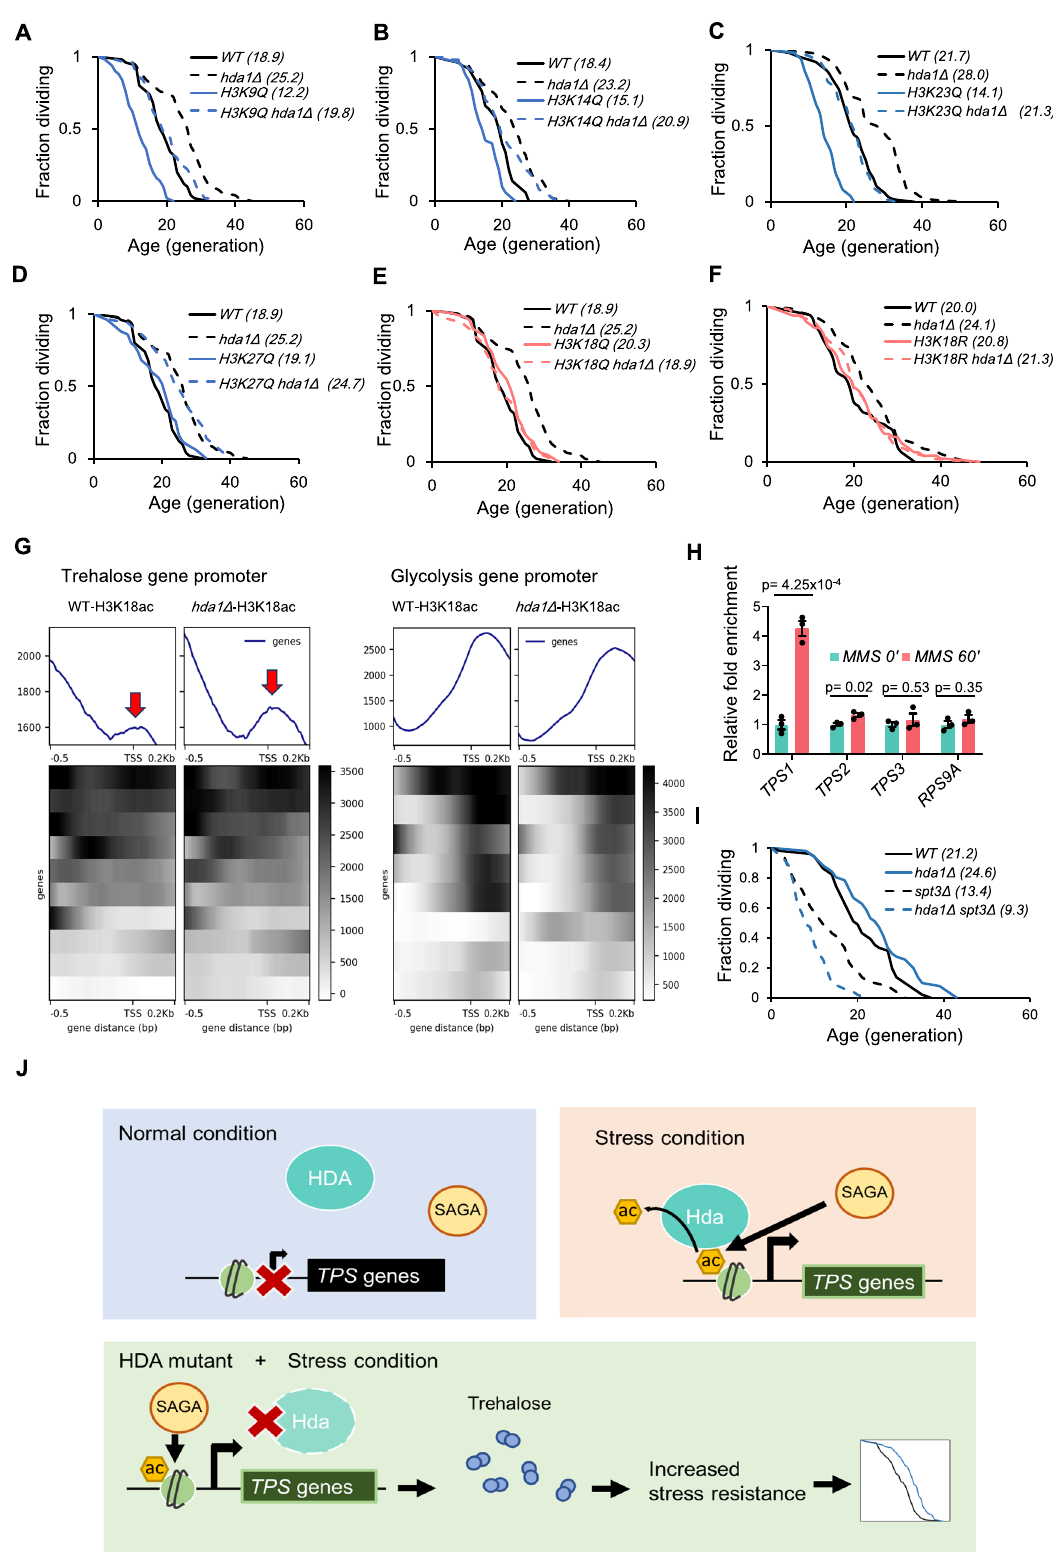
Fig. 7 The lifespan phenotypes of HDA mutants are mediated by H3K18 acetylation. A RLS of WT, hda1 Δ , H3K9Q , and hda1 Δ H3K9Q . B RLS of WT, hda1 Δ , H3K14Q , and hda1 Δ H3K14Q . C RLS of WT, hda1 Δ , H3K23Q , and hda1 Δ H3K23Q . D RLS of WT, hda1 Δ , H3K27Q , and hda1 Δ H3K27Q . E RLS of WT, hda1 Δ , H3K18Q , and hda1 Δ H3K18Q . F RLS of WT, hda1 Δ , H3K18R , and hda1 Δ H3K18R . G Metagene plot and heatmap of H3K18 acetylation on trehalose (left) and glycolysis (right) promoters as detected by ChIP- Seq. H ChIP-qPCR of Hda1-myc binding on TPS1, TPS2, TPS3 , and ACT1 promoters, under designated time after MMS treatment. Error bars represent SEM, n = 3. p -value calculated by two-sided T- test. I RLS of WT, hda1 Δ , spt3 Δ , and hda1 Δ spt3 Δ . J Mechanism of HDA mediated suppression of trehalose metabolism and its effect on yeast aging. See also Figure S4.